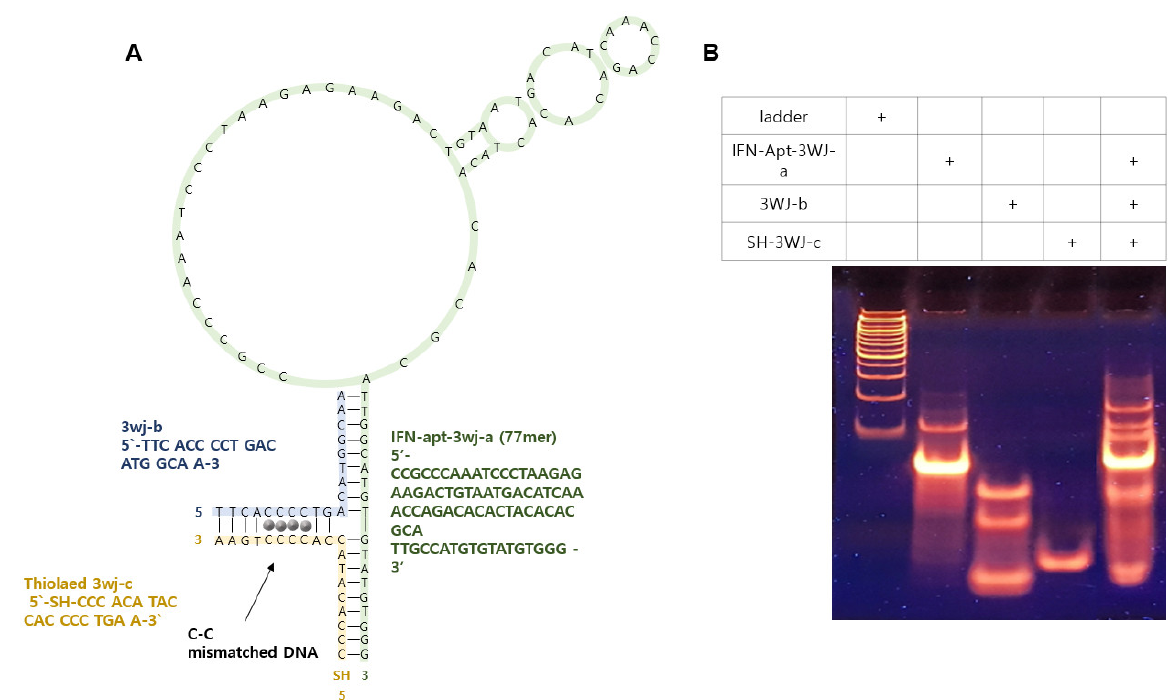
Figure 3. ( A ) Schematic diagram of MF-3WJ predicted by folding. ( B ) TBE PAGE confirmed to DNA 3WJ assembly and DNA ladder (lane 1), IFN-γ-Apt-3wj-a (lane 2), 3wj-b (lane 3), SH-3wj-c (lane 4), and MF-3WJ (lane 5) .